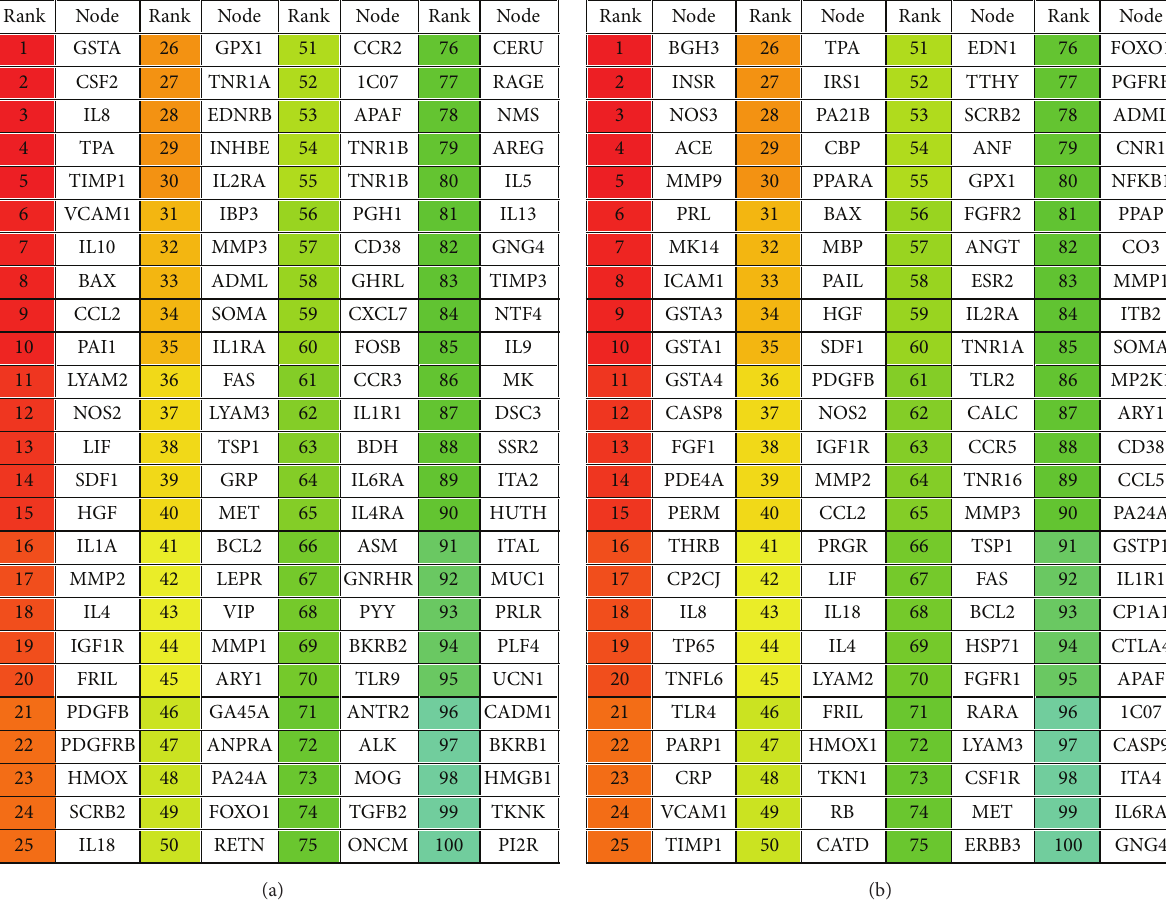
Figure 3: (a) Hub proteins identified in the human structural protein interaction network. (b) Hub proteins identified in the human neurological protein interaction network. The hubs are ranked in the decreasing order of